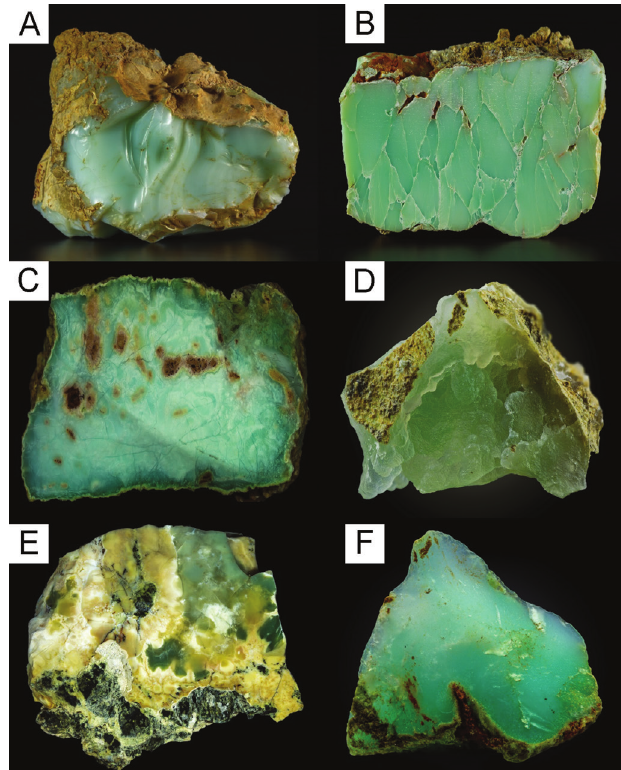
Figure 1. Different color varieties of chrysoprase from Lower Silesia (Poland): A – opal chrysoprase (prazopal), Szklary; B – light green chrysoprase, Szklary; C – matrix chrysoprase, Wiry; D – botryoidal chrysoprase, Szklary; E – matrix chrysoprase, Szklary; F – chalcedony chrysoprase, Szklary. Photos by P.